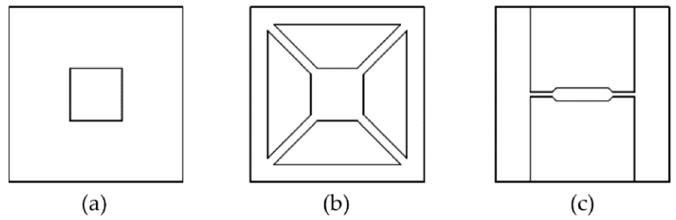
Figure 4. Top view of microhotplates with different configurations: ( a ) closed membrane; ( b ) suspended membrane; ( c ) bridge.